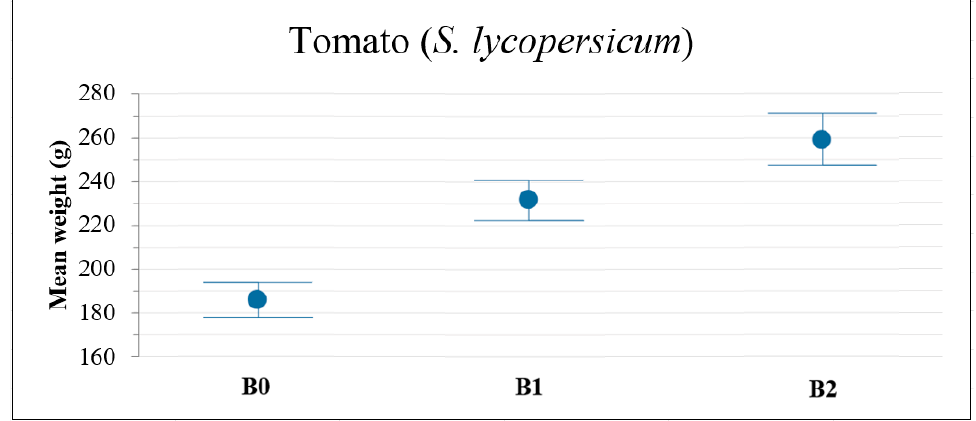
Figure 5. Mean tomato weight and confidence interval of each treatment ( α =